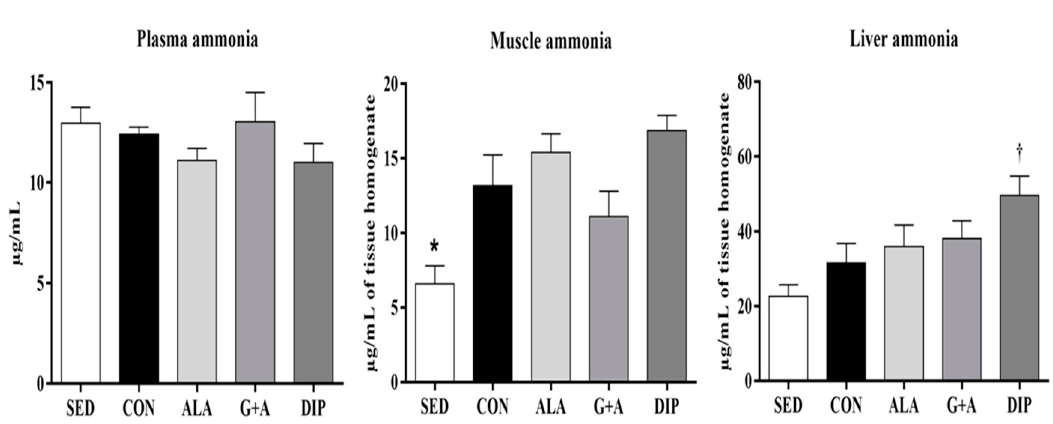
Figure 5. Plasma, muscle, and liver ammonia of rats submitted to resistance training and supplementation with L -glutamine and L -alanine. SED: sedentary group, CON: trained group, ALA: trained and supplemented with alanine, G + A: trained and supplemented with glutamine and alanine in their free form, and DIP: trained and supplemented with L -alanyl- L -glutamine. * p < 0.05 vs. CON, ALA, and DIP. † p < 0.05 vs. SED. Data are presented as mean ± SD.